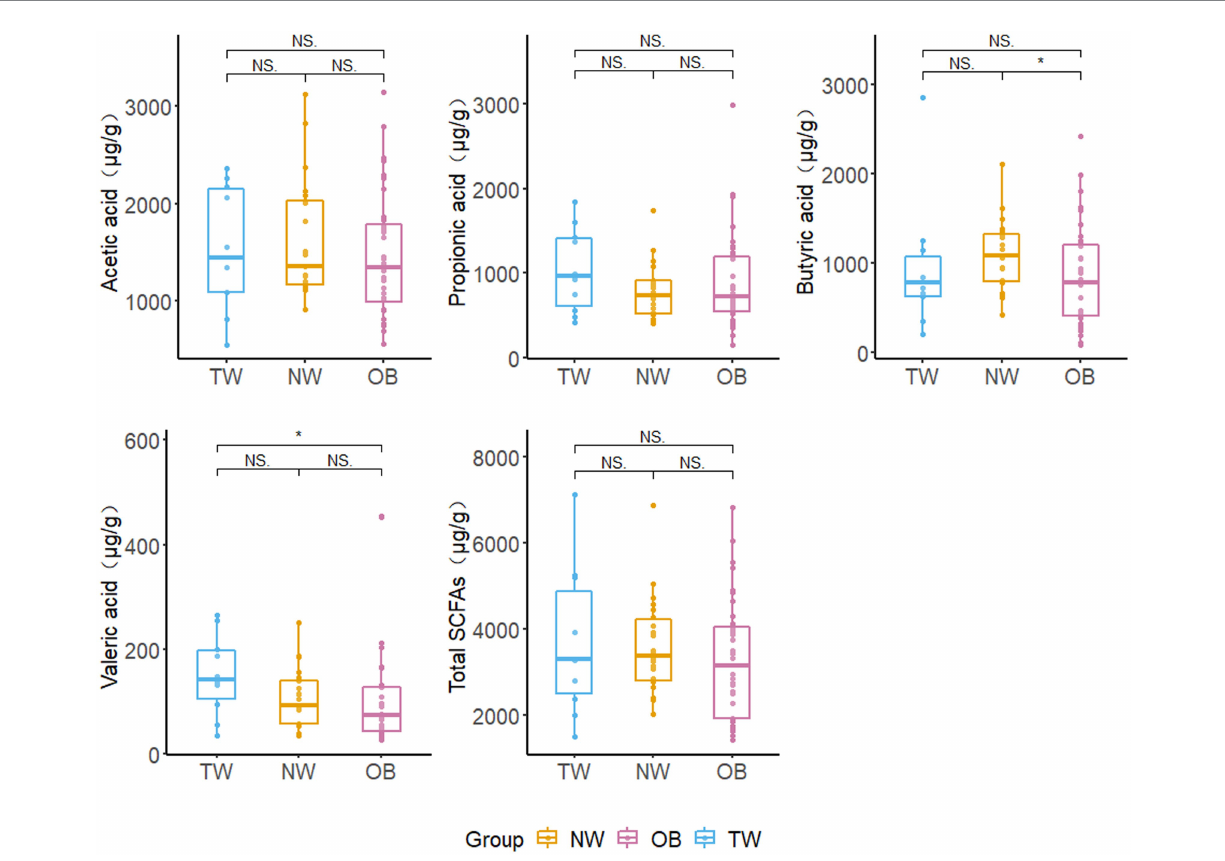
FIGURE 8 Fecal SCFA contents in different groups. Box and whisker plots represent the median, interquartile range, and minimum and maximum values for the SCFA content in each group. Asterisks above the boxes indicate significant differences ( p < 0.05). t -test was used to test for significant differences in statistics. NS p > 0.05, * p ≤ 0.05, and ** p ≤